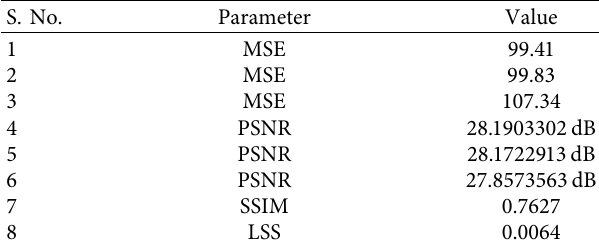
Table 4: Evaluation